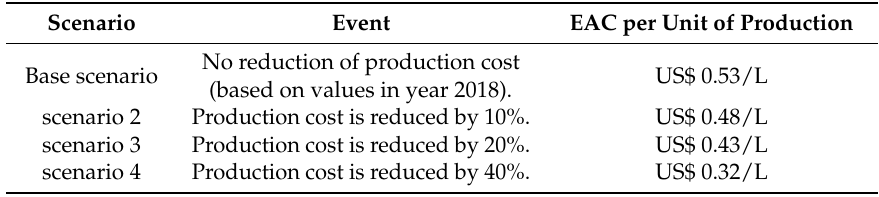
Table 5. EACs per unit of 2G ethanol produced for different scenarios of production